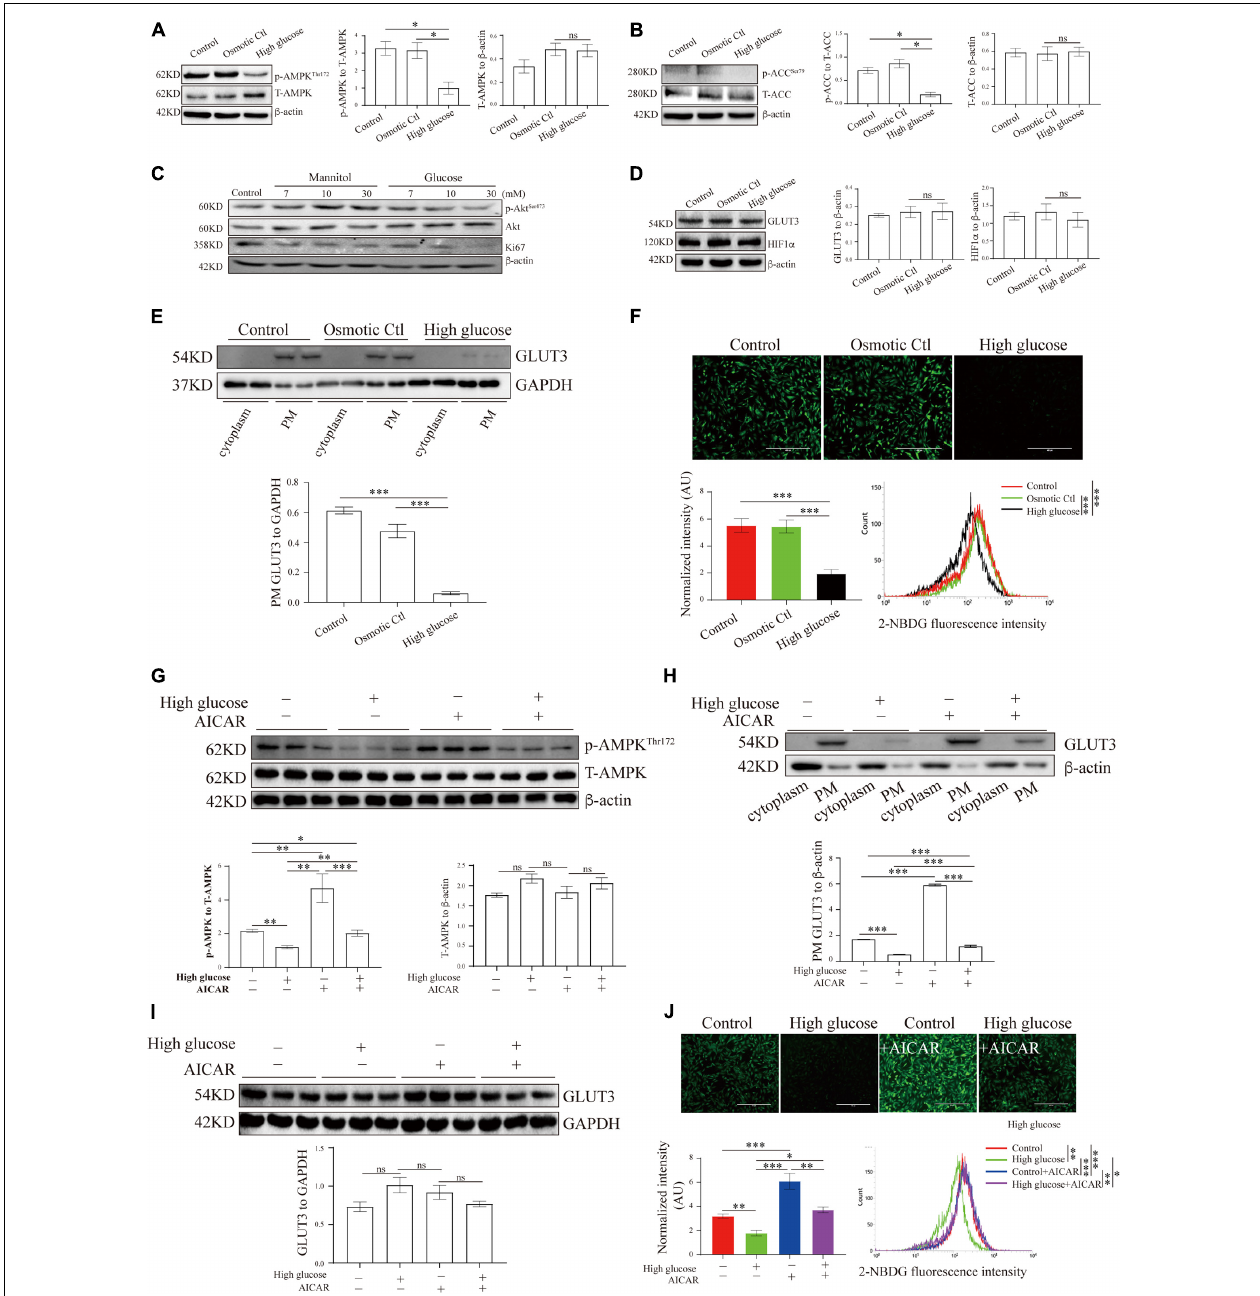
FIGURE 3 | AMP-activated protein kinase signaling and GLUT3 trafficking were manipulated in an in vitro trophoblastic GDM model. HTR8/SVneo cells were treated with 11.1 mM D-glucose + 18.9 mM mannitol (osmotic control), 30 mM glucose (high glucose) or 11.1 mM D-glucose (control) and were then subjected to Western blotting analyses of (A) the p-AMPK and AMPK levels ( n = 6), (B) the p-ACC and ACC levels ( n = 6), (C) the Ki67, p-Akt and Akt levels ( n = 6), (D) the total GLUT3 and HIF-1 α protein levels ( n = 4) and (E) the membranous GLUT3 levels ( n = 4). PM GLUT3 was normalized to GAPDH. (F) Representative fluorescence images from each group after incubation with 2-NBDG for 30 min are shown. Bar: 400 µ m. The fluorescence intensity of 2-NBDG taken up by HTR8/SVneo cells was measured by flow cytometry at 488/530 nm ( n = 4). The intensity of each experiment was calculated using flow cytometry software, and the intensity was normalized to the cell number. (G) p-AMPK and AMPK levels in HTR8/SVneo cells treated with vehicle or 100 µ M AICAR for 24 h in the presence of a high or normal concentration of glucose ( n = 6). (H) Subcellular GLUT3 distribution after the treatments ( n = 4). PM GLUT3 was normalized to β -actin. (I) Total GLUT3 protein levels ( n = 6). (J) Representative fluorescence images of 2-NBDG obtained from each group after 24 h of treatment with vehicle or AICAR. Bar: 400 µ m. The fluorescence intensity of 2-NBDG was measured at 535/485 nm by flow cytometry ( n = 4). The analysis was in line with that presented in panel (F) . The data that are presented as the means ± SEMs are annotated in normal font, and ordinary ANOVA test was used among multiple groups. The data presented as the medians (IQRs) are shown in bold font, and Kruskal-Wallis test was used among multiple groups. ∗ p < 0.05, ∗∗ p < 0.01, and ∗∗∗ p < 0.001.